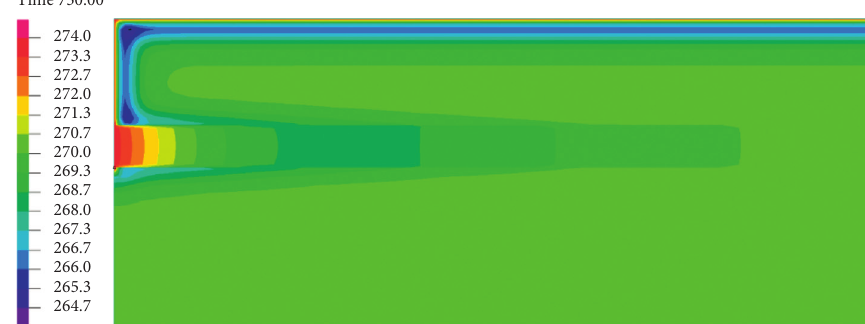
Figure 13: Average temperature distribution inside a tunnel with a 500m length.